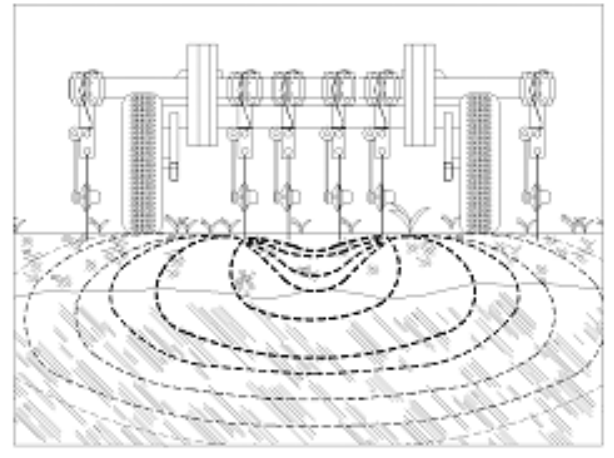
FIGURE 4. The Veris  3100 soil conductivity mapping system employs two arrays to investigate soil at two depths, 0 to 25 cm and 0 to 75